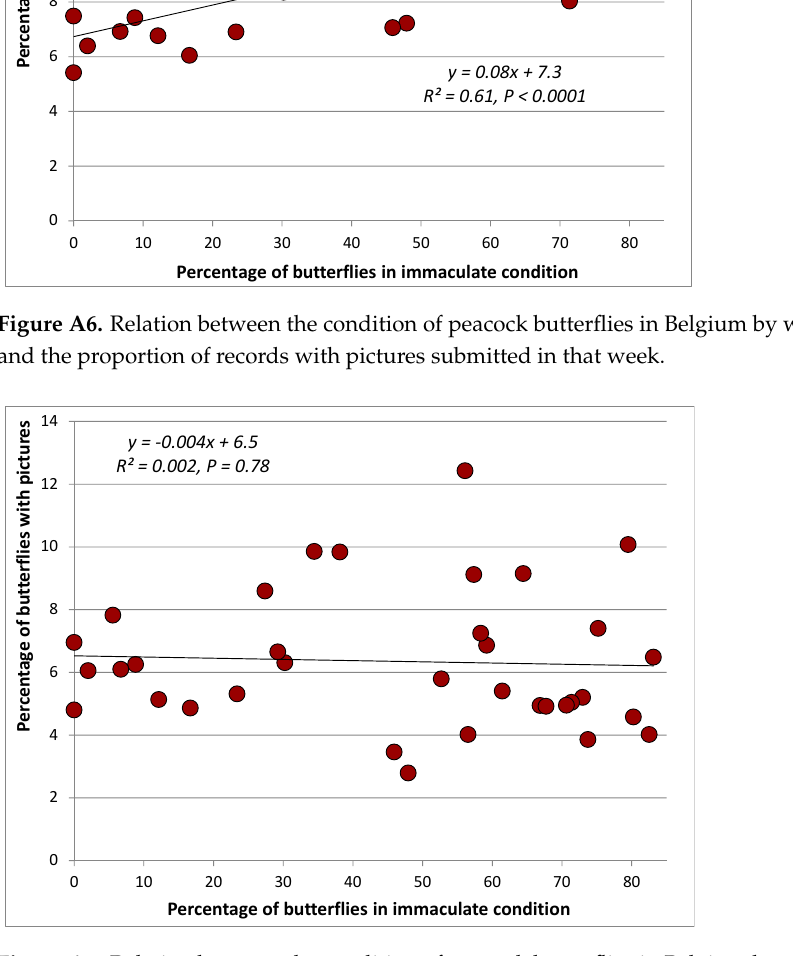
Figure A7. Relation between the condition of peacock butterflies in Belgium by week (weeks 10–44) and the proportion of butterflies illustrated with pictures submitted in that week.